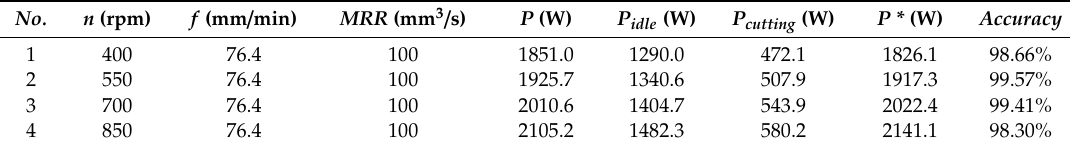
Table 3. Cutting conditions and power dada in Experiment-II.